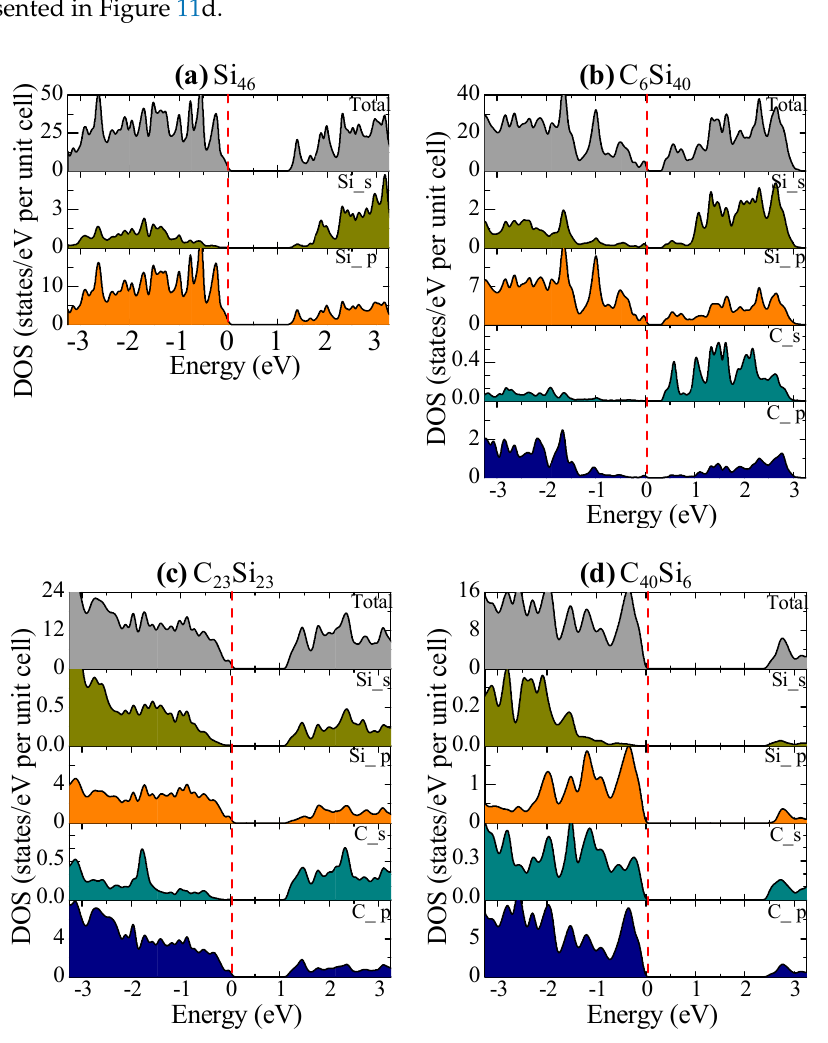
Figure 11. The total and s –, p –orbital projected density of states of ( a ) Si 46 , ( b ) C 6 Si 46 , ( c ) C 23 Si 23 , and ( d ) C 40 Si 6 . The Fermi level (red dashed line) is referenced at the top of the valence band at zero eV. From Chan and Peng [24]. Reprinted with permission from Springer.